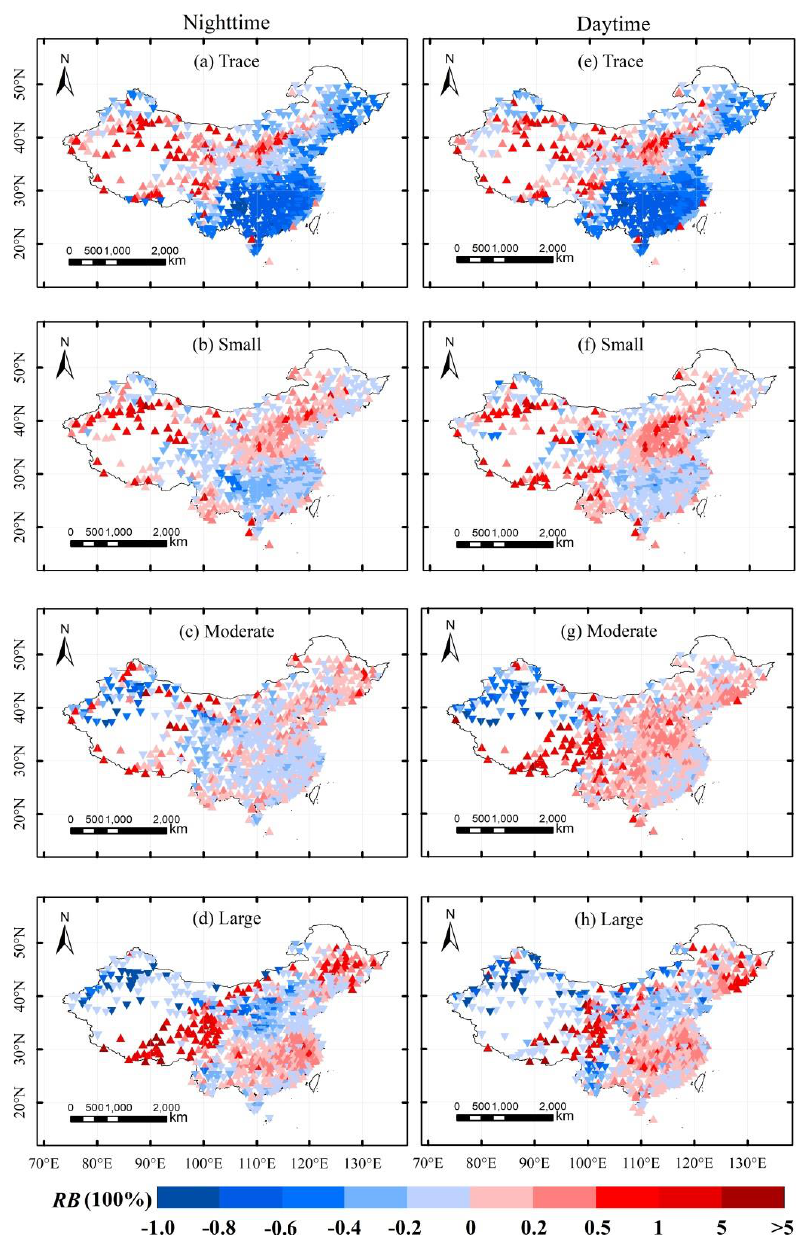
Figure 8. Spatial distribution of relative bias from TRMM 3B42 data and gauge data for precipitation frequencies during ( a – d ) nighttime and ( e – h ) daytime for di ff erent categories of intensity over mainland China. From top to bottom are days with a trace amount of rain ((0.1 ≤ P < 1 mm (12 h) − 1 )), a small amount of rain (1 ≤ P < 10 mm (12 h) − 1 ), a moderate amount of rain (10 ≤ P < 25 mm (12 h) − 1 ), and a large amount of rain (P ≥ 25 mm (12 h) − 1 )). Regular or inverted triangles represent stations that have a positive or negative relative bias, respectively.